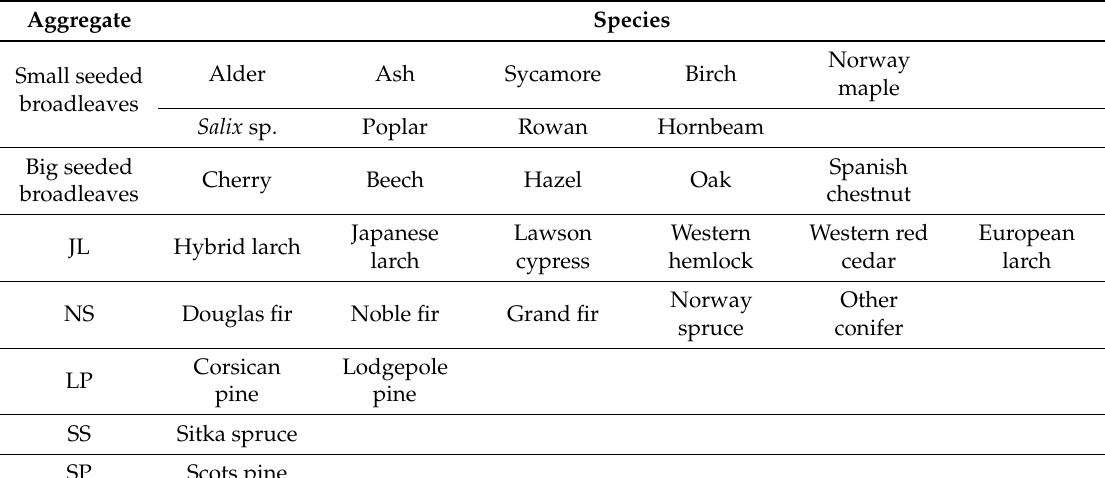
Table A7. Species aggregated into groups for the purpose of assigning red squirrel habitat suitability scores.